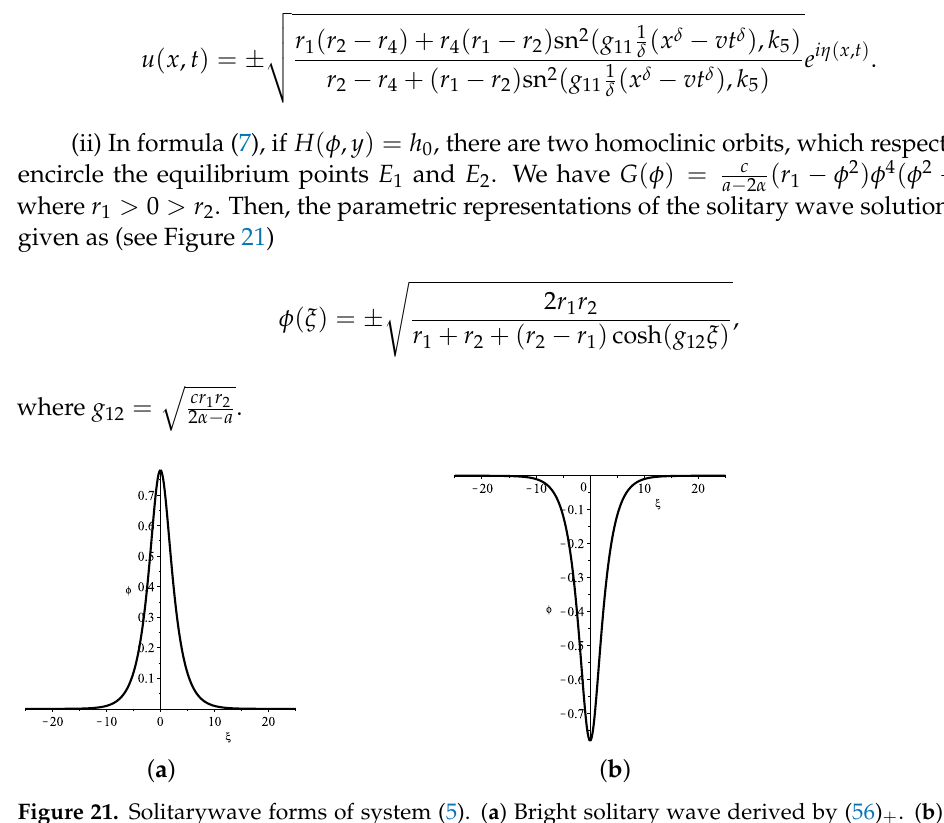
Figure 21. Solitarywave forms of system (5). ( a ) Bright solitary wave derived by (56) + . ( b ) Dark solitary wave derived by (56) −